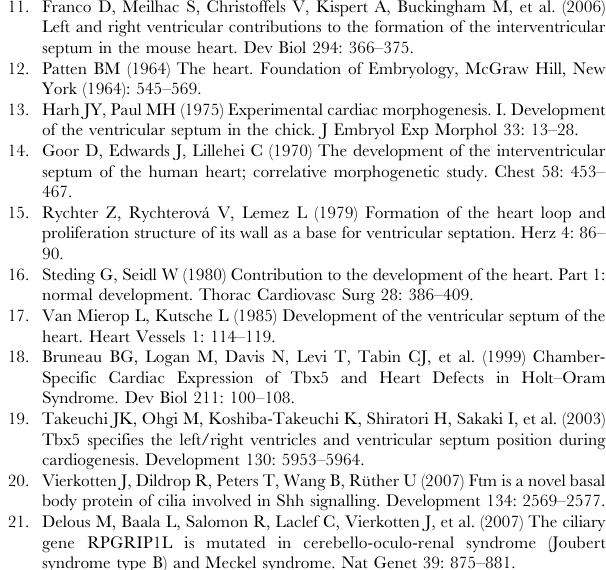
Figure S9 Endocardial cushion development is not altered in Ftm -negative embryos. (A, B) In situ hybridiza- tions on heart sections at E11.5. Endocardial cushion marker expression of Msx1 is unchanged in Ftm -deficient, murine hearts (compare inlets in A and B). (C) Proliferation rate is determined by the relation of dividing (BrdU-marked) ECCs to the number of all ECCs in this region at E11.5 ( Ftm + / + : n= 3 hearts; Ftm 2 / 2 : n = 3 hearts). The number of proliferating ECCs is not significantly altered in Ftm -negative hearts. (D, E) Immunofluorescence on transverse heart sections at E11.5. ECC cilia are marked in red by Arl13b. Scale bars (in white) represent a length of 2 m m. (D) Gli3 (green) is missing at ECC cilia. (E) Ftm (green) is present at ECC cilia. Table S1 Phenotypes of all analyzed Ftm -negative embryos. The phenotypes of all analyzed Ftm -negative embryos in the developmental stages E13.5 to E17.5 is depicted in this table. The ‘‘x’’ symbolizes the appearance of the defect. pVSD, perimembranous ventricular septal defect; mVSD, muscular ventricular septal